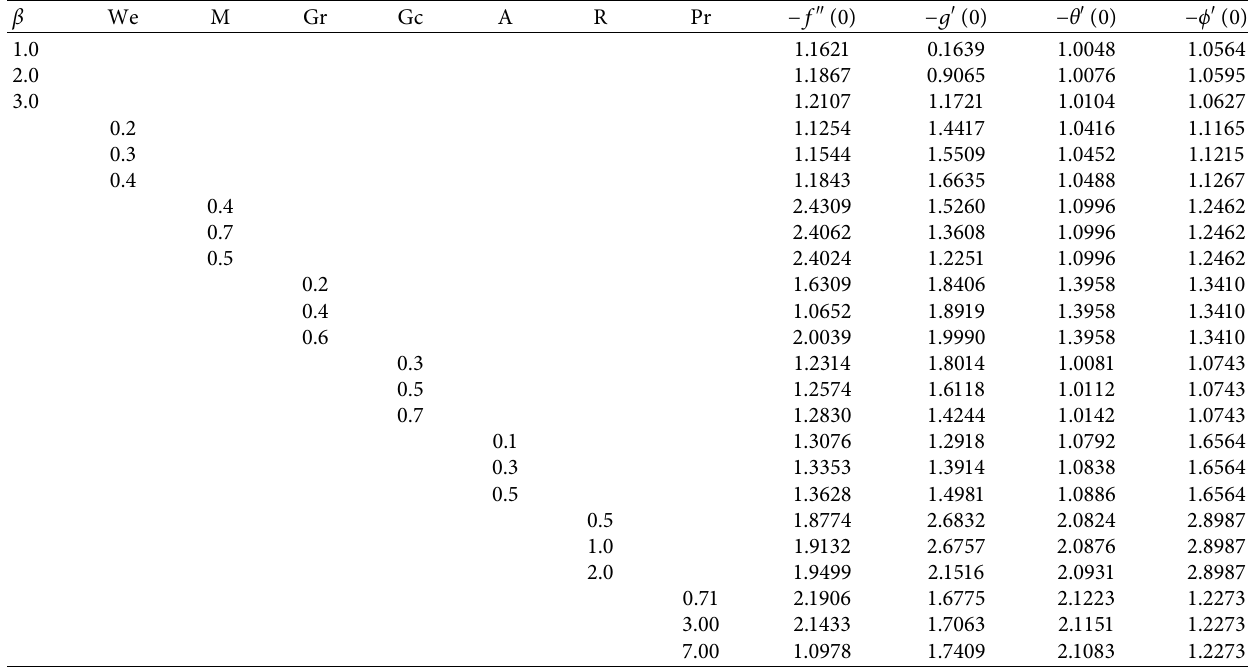
Table 1: Computational values of skin friction, Nusselt number, and Sherwood number for key fow parameters.